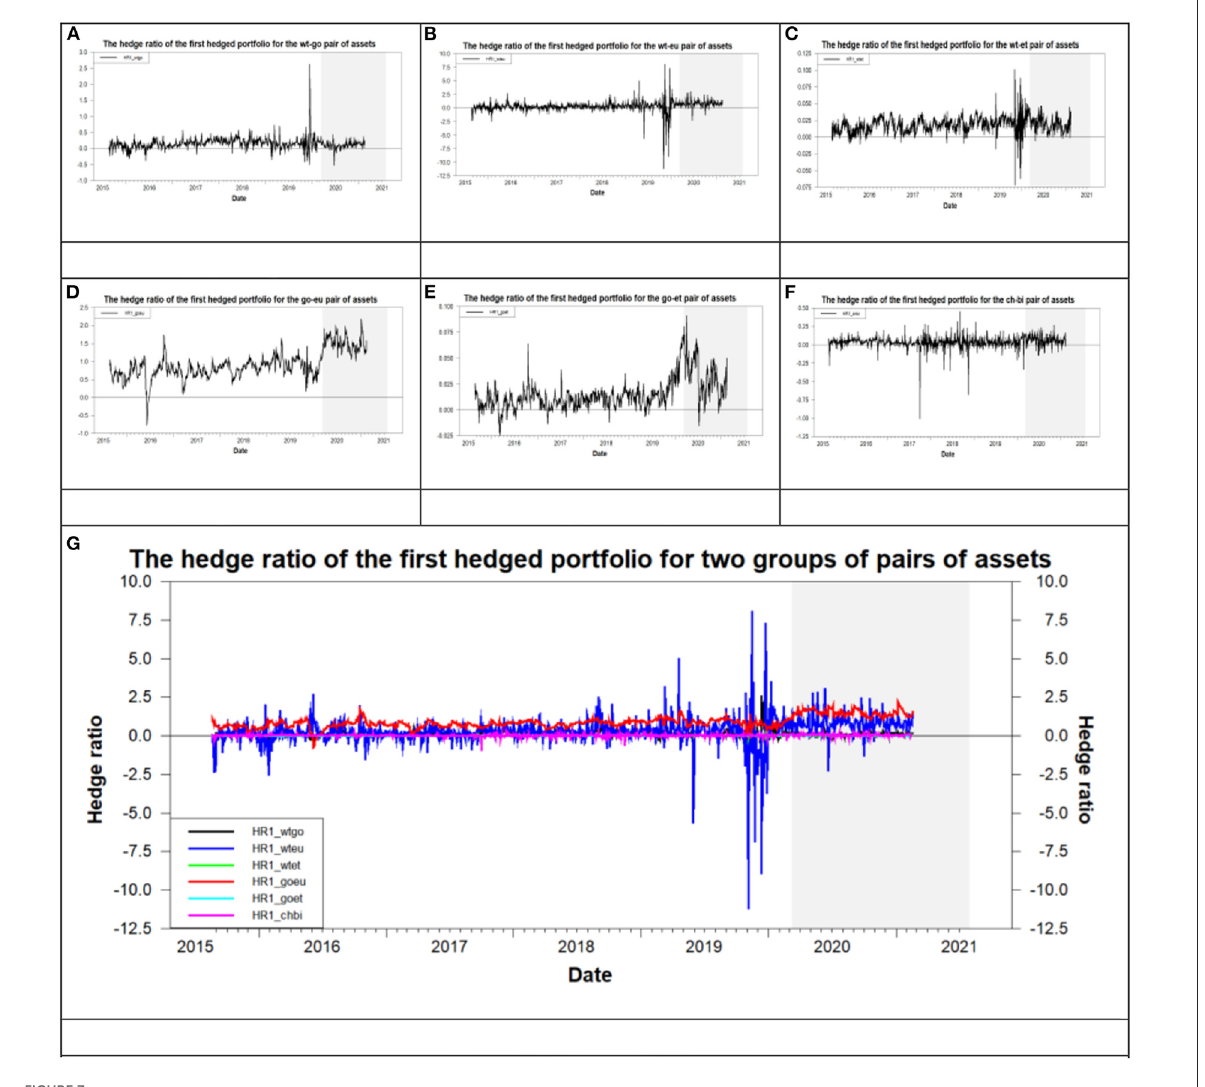
FIGURE7 The time-varying hedge ratio for the six pairs of assets. (A) wt-go, (B) wt-eu, (C) wt-et, (D) go-eu, (E) go-et, (F) ch-bi, and (G) all six pairs of